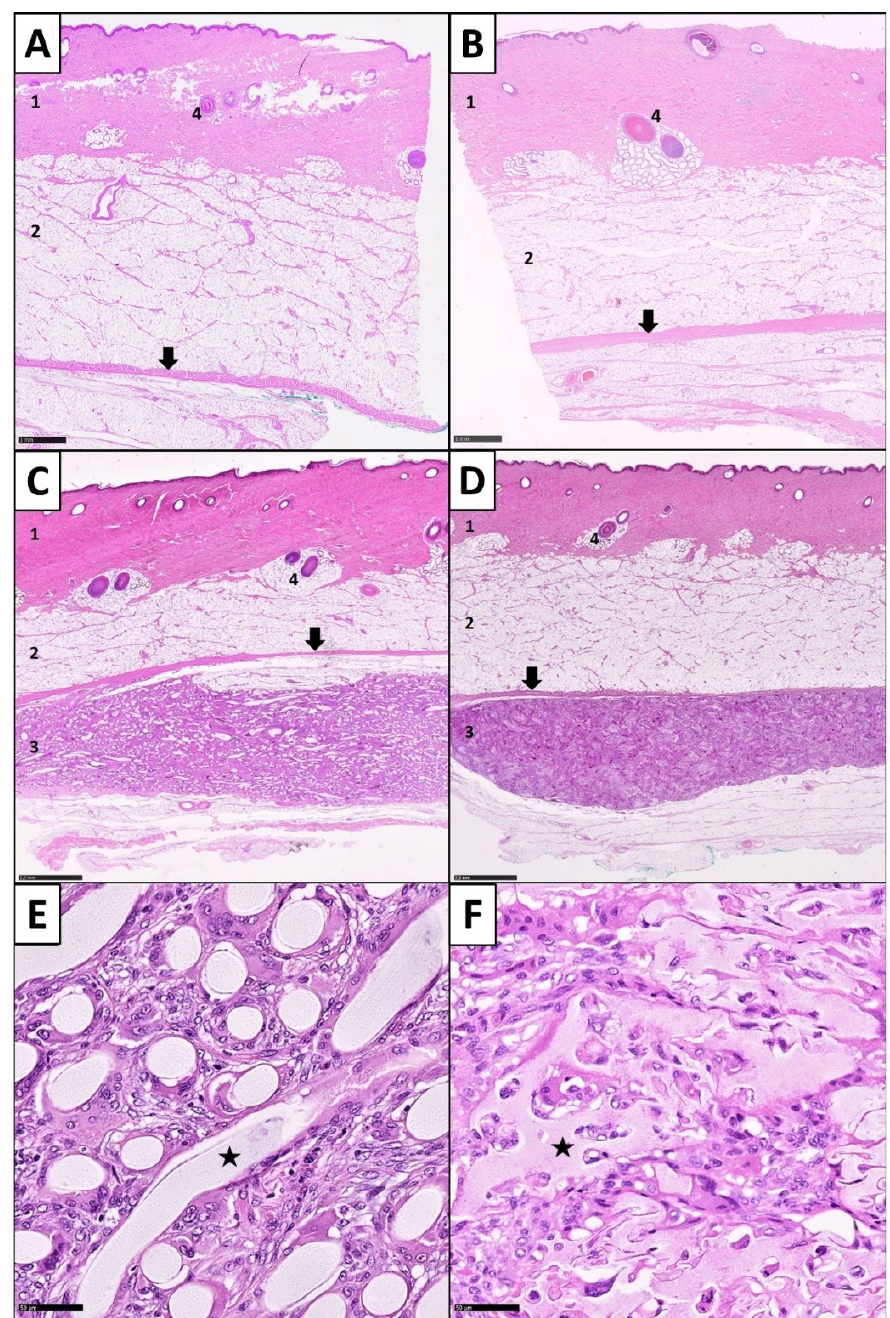
Figure 5. Histopathological evaluation of the overall skin morphometry and biomaterial effects on the surrounding tissue after subcutaneous implantation period ( A , B ): Healthy controls of the surrounding skin of the testfields: note the typical zonal morphology: 1 epidermal and dermal layer, 2 subcutaneous fat layer, 4 hair bulges and sweat glands. Arrows point to the fascia superficialis, H&E staining. ( C ) Slide overview after subcutaneous implantation of a filamentous fleece and ( D ) a sponge-like biomaterial. Normal configuration and zonal morphology of the skin with 1 epidermal and dermal layer and 2 subcutaneous fat layers. Below the fascia superficialis (arrow), the biomaterial zone with the implanted scaffolds (3) can be identified, H&E staining. ( E ) Microscopic close-up image of the scaffold zone of a filamentous biomaterial (star), H&E staining, magnification × 200. ( F ) Microscopic close-up image of the scaffold zone of a sponge-like biomaterial (star), H&E staining, magnification ×